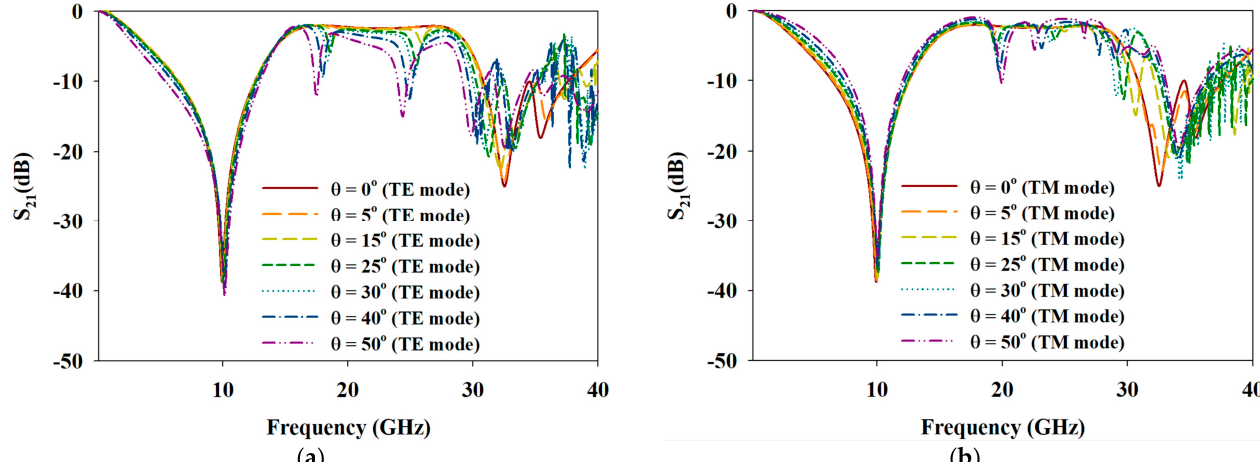
Figure 6. Simulated responses of opaque MFSS under the influence of oblique angle variations of ( a ) TE mode and ( b ) TM mode incidents.